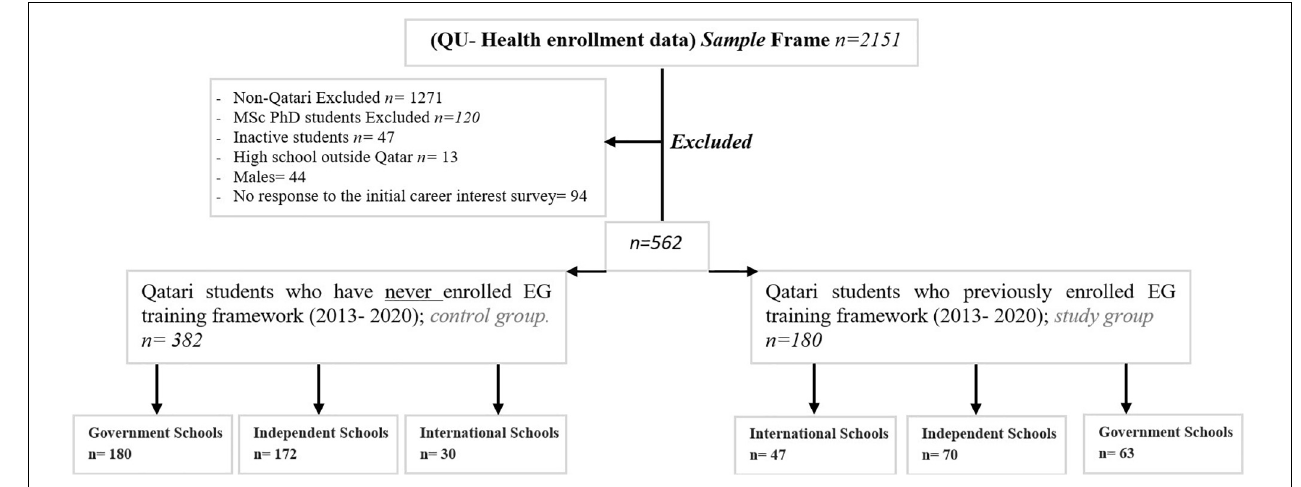
FIGURE 2 | Case-control study design.